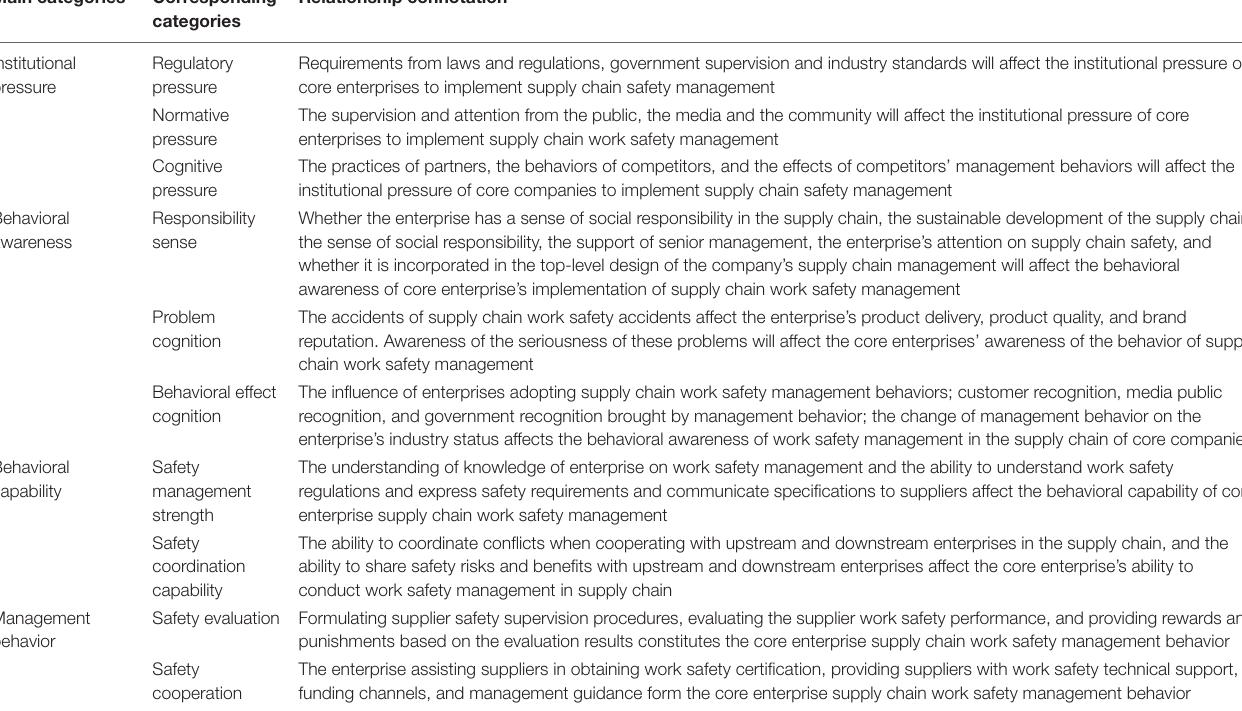
TABLE 3 | The main categories formed by the axial coding.